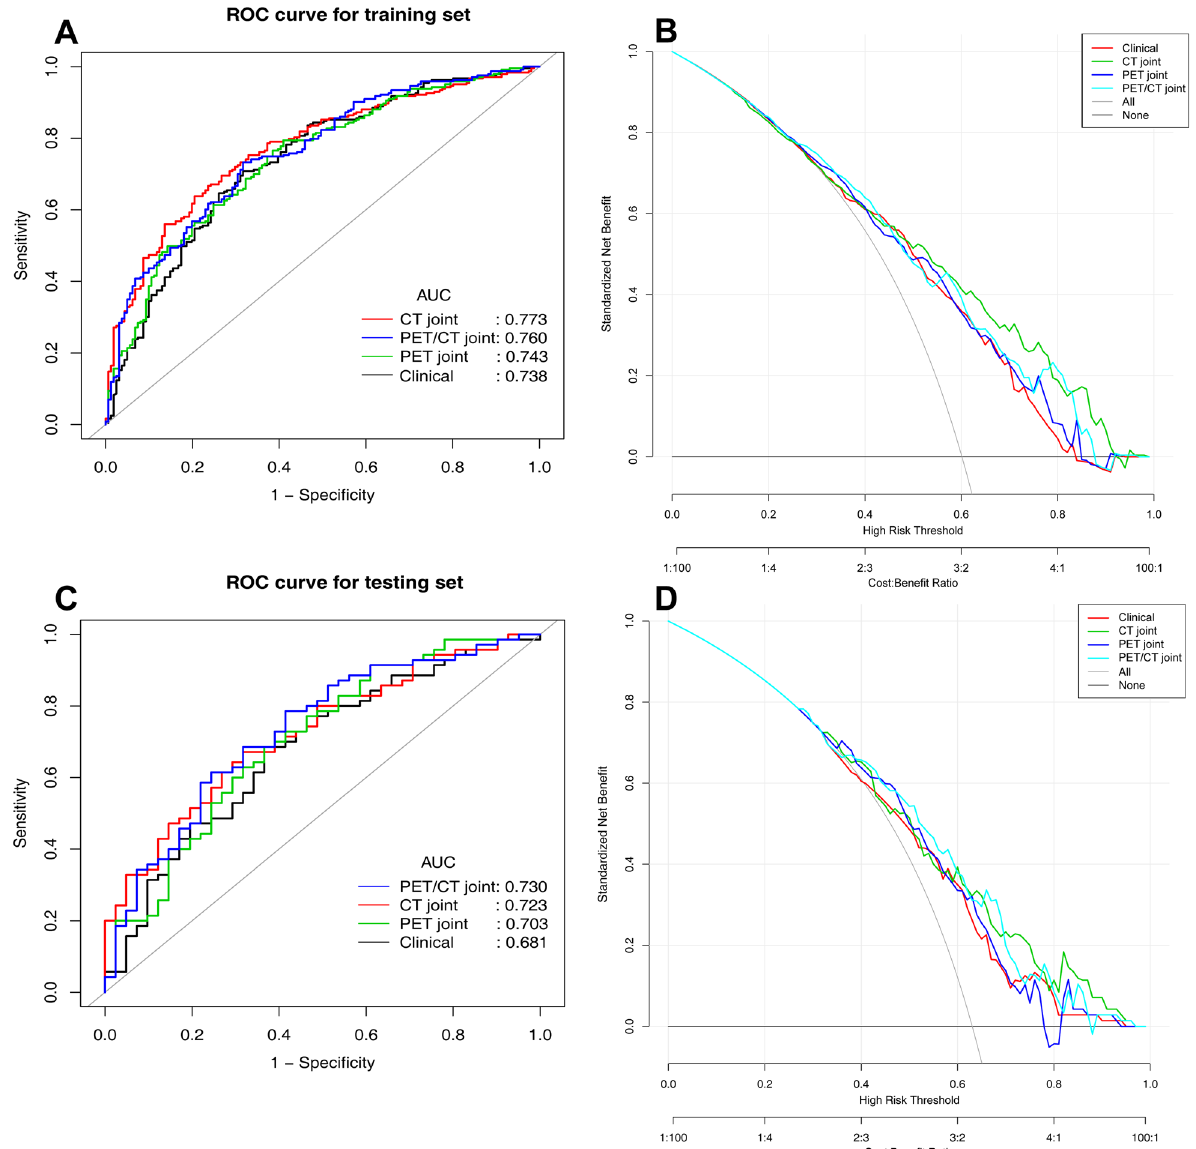
Fig. 4 ROC and DCA curves of the clinical model and CT, PET, PET/CT joint model in the training set ( A – B ) and testing set ( C – D ). ROC receiver operating characteristic, AUC area under the